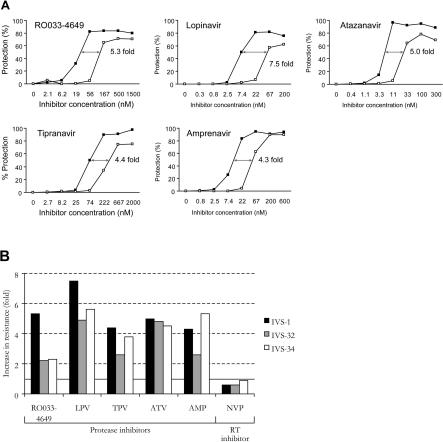
Determination of Phenotypic Drug Susceptibility of the In Vitro-Selected Virus Populations(A) Investigation of phenotypic drug susceptibility of IVS-1 (open squares) as compared to wild-type HIV (HXB2; filled squares) to the protease inhibitors RO033-4649, lopinavir, tipranavir, atazanavir, and amprenavir. Fold increases in IC50 are indicated.(B) Representation of the fold increases in phenotypic drug resistance of IVS-1, IVS-32, and IVS-34 as compared to wild-type HIV (HXB2) to the PI R0033–4649, lopinavir (LPV), tipranavir (TPV), atazanavir (ATV), and amprenavir (AMP), and as a control to the RT inhibitor nevirapine (NVP).